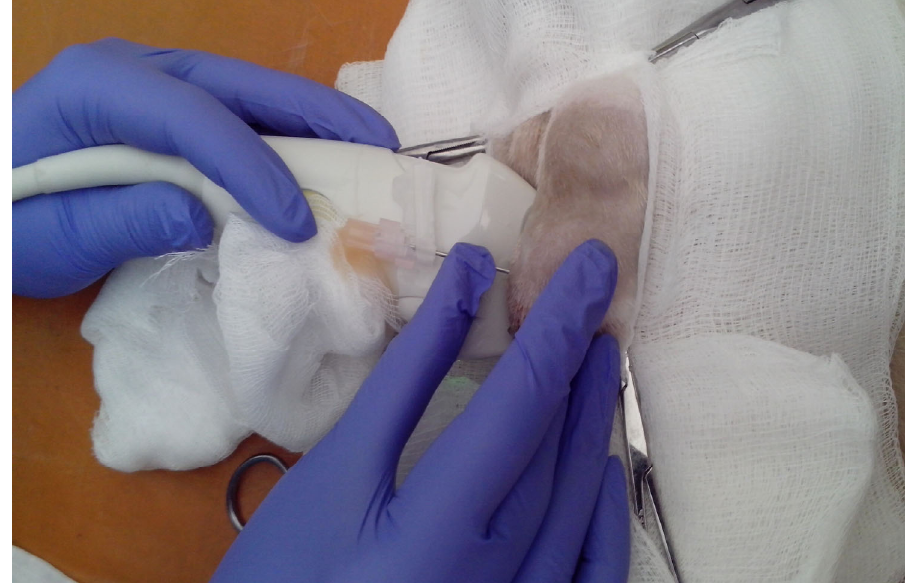
Fig. 1. Performing a targeted fine-needle biopsy under ultrasound